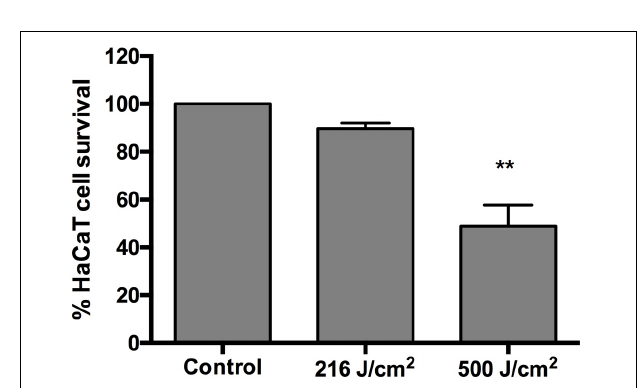
FIGURE 4 | Cytotoxicity of 405-nm aBL to normal human HaCaT cells after an exposure of 216 J/cm 2 (60 mW/cm 2 , 60 min) or 500 J/cm 2 (92.6 mW/cm 2 , 90 min). 0 vs 216 J/cm 2 ( P = 0.4016) and 0 vs 500 J/cm 2 ( P = 0.0011). Bars are the SE. ∗∗ P <